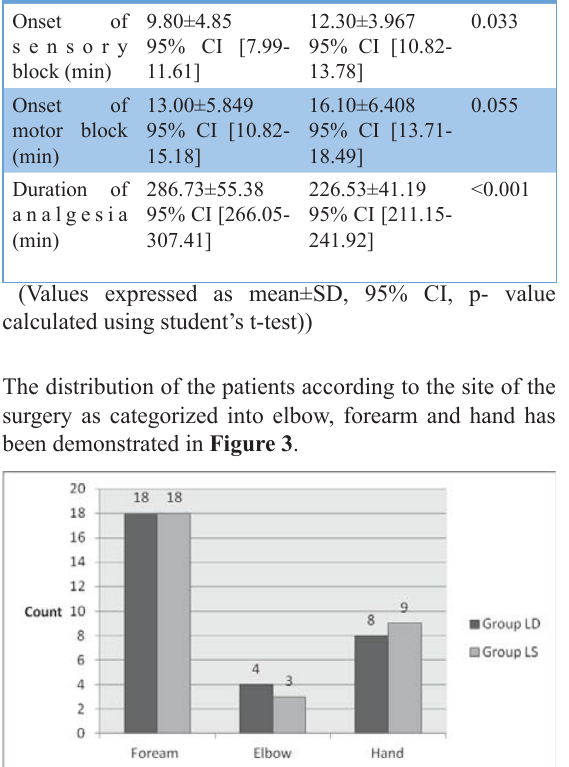
The details of onset of sensory block and motor block and